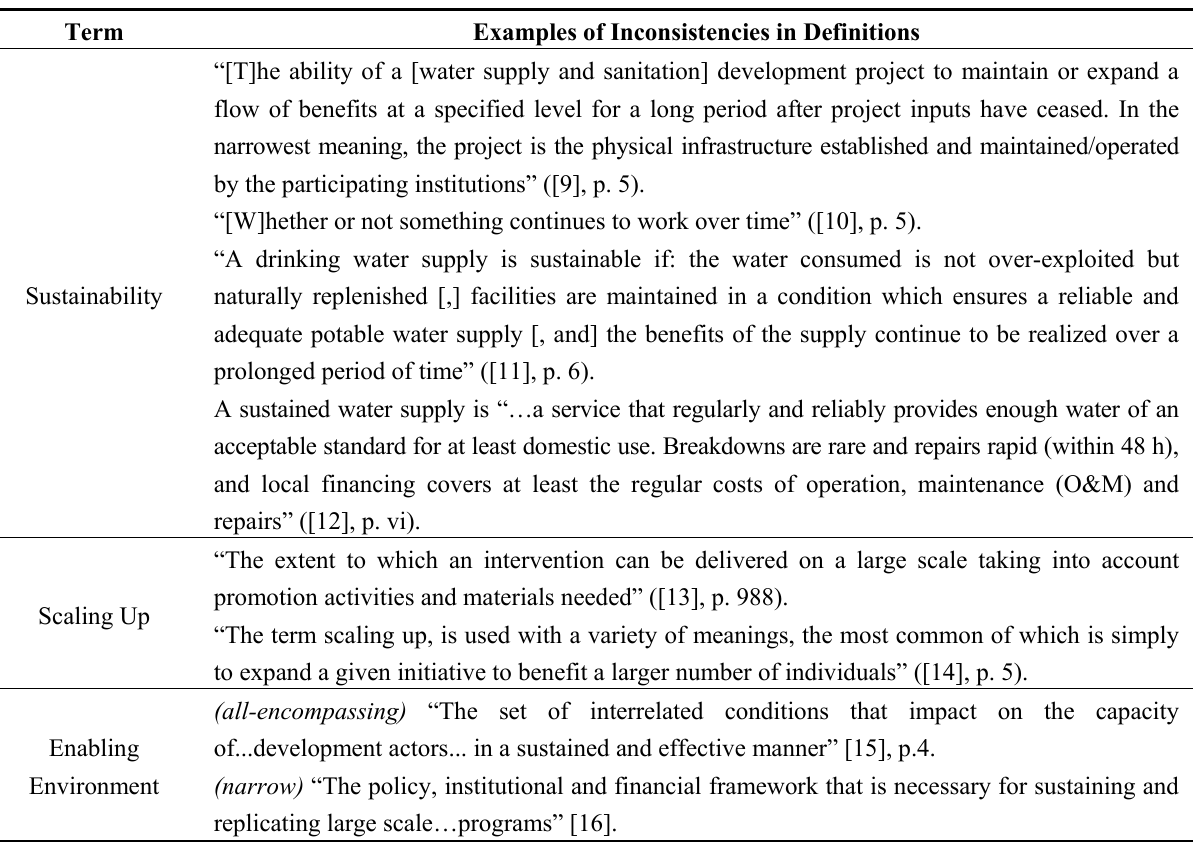
Table 1. Examples of inconsistencies in definitions of sustainability, scaling-up, enabling